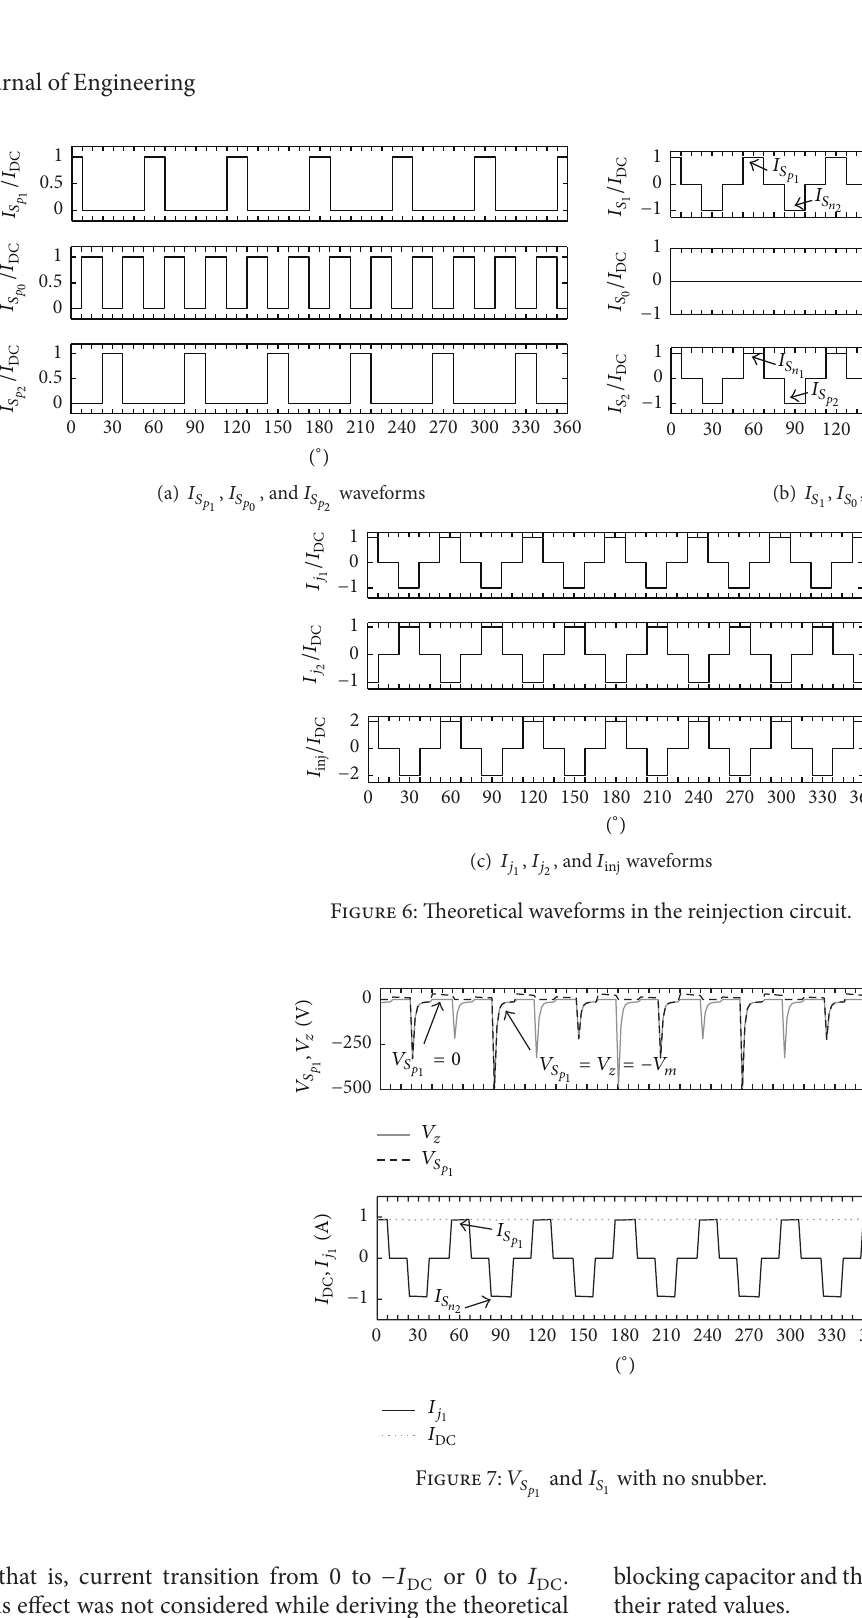
and 𝐼 𝑆 with no 𝑝1 1